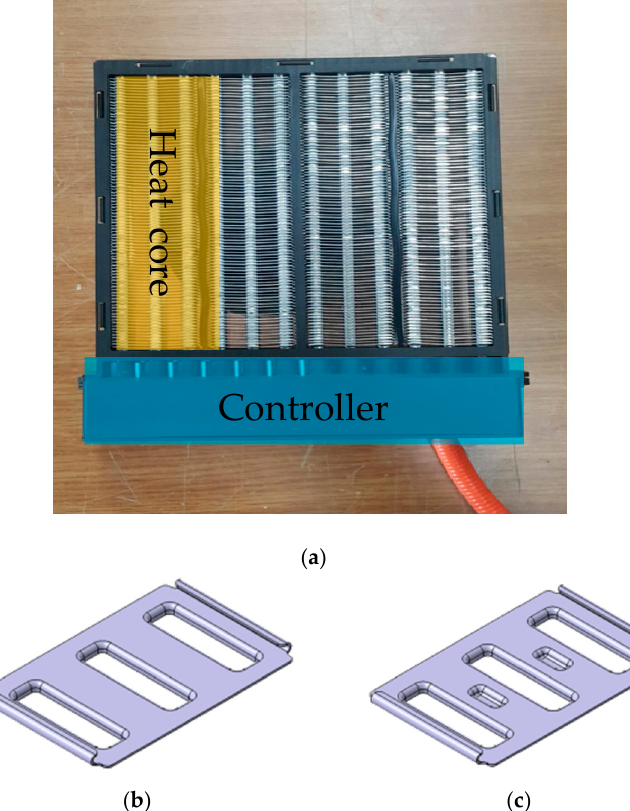
Figure 1. High voltage PTC heater and radiation fin. ( a ) High-voltage PTC heater Design; ( b ) Heater A: plate fin type; ( c ) Heater B: emboss fin type. Table 1. Specification of PTC Heater A and B.